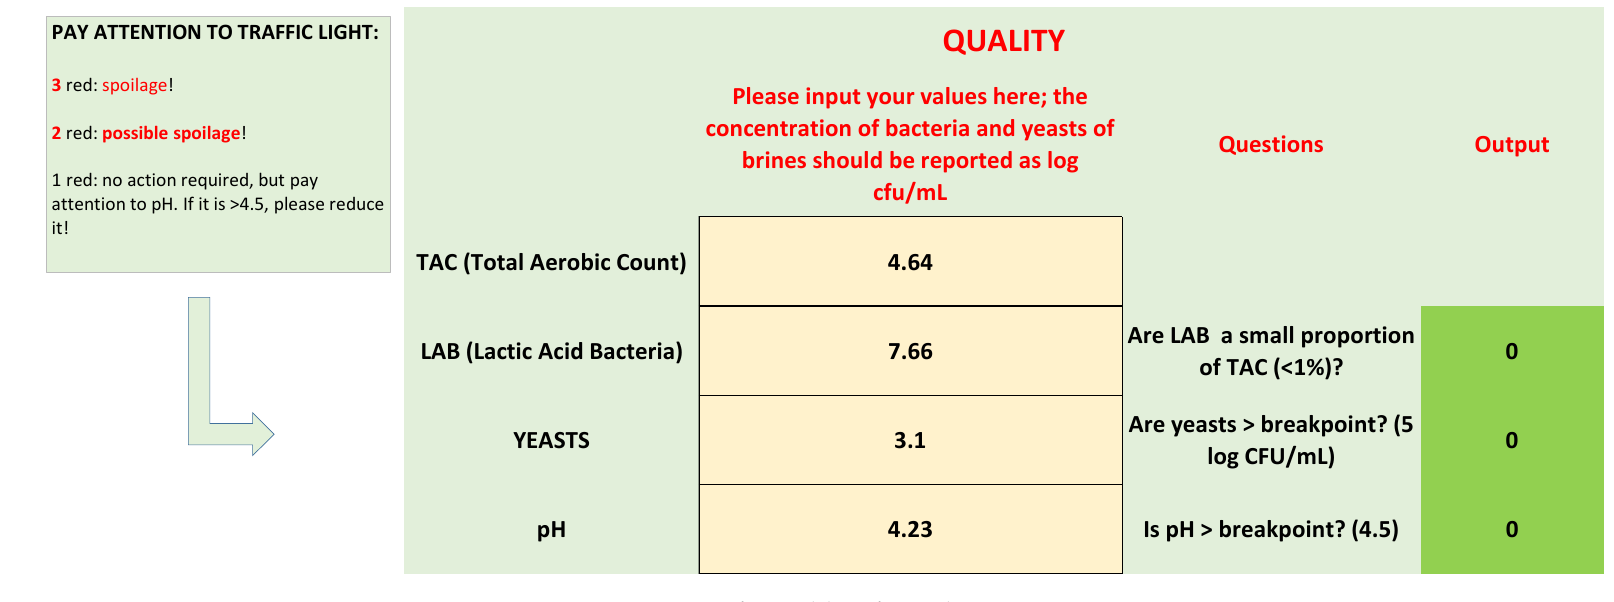
Figure 3. Section of spreadsheet for quality parameters.